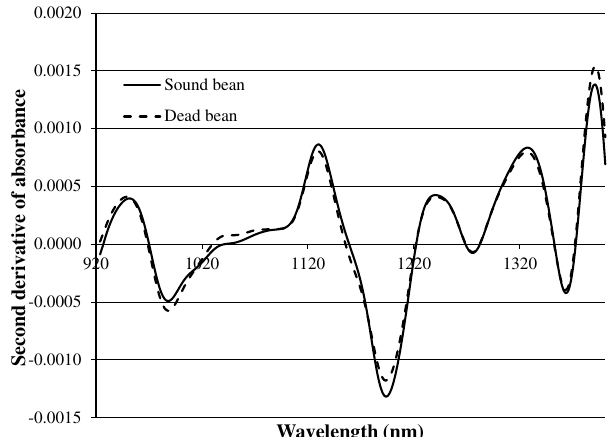
Fig. 4. Second derivative of absorbance for sound and dead mung bean seeds.